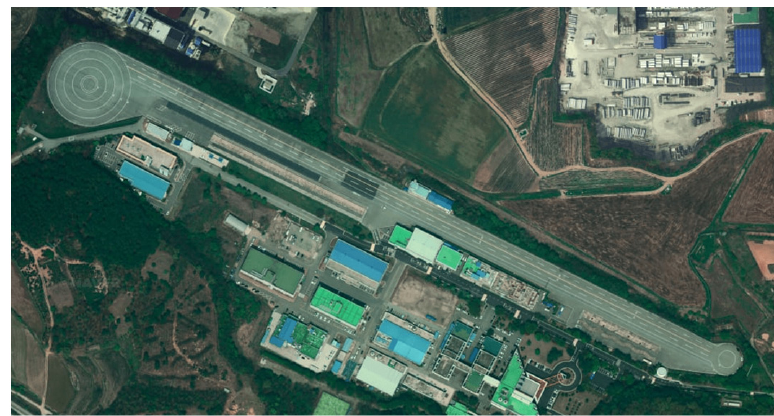
Figure 8. Proving ground at the Korea Automotive Technology Institute.